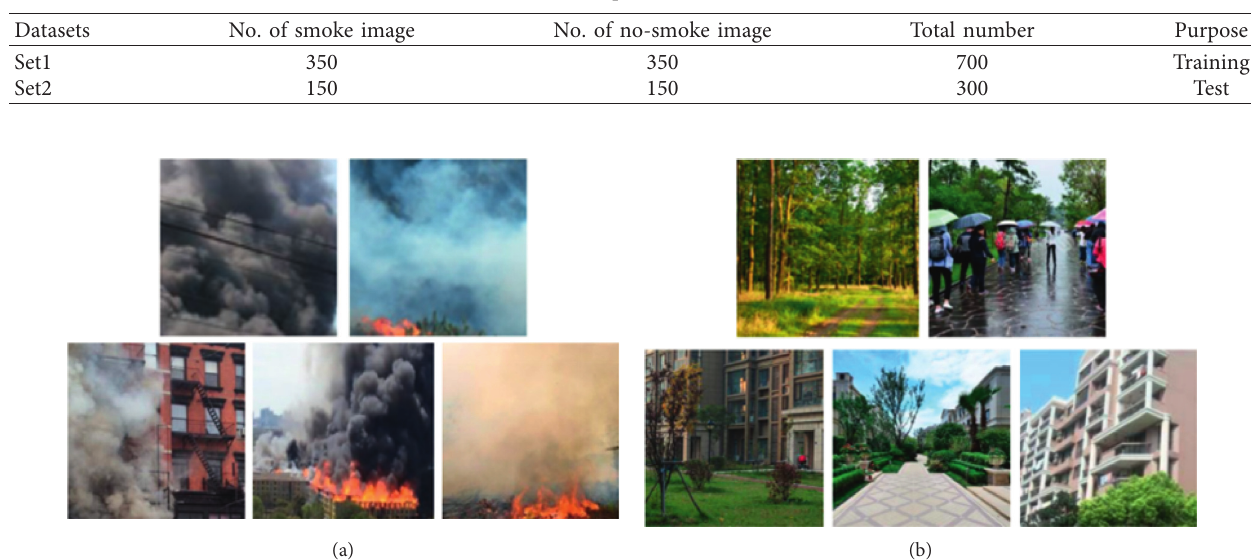
Table 2: Experimental